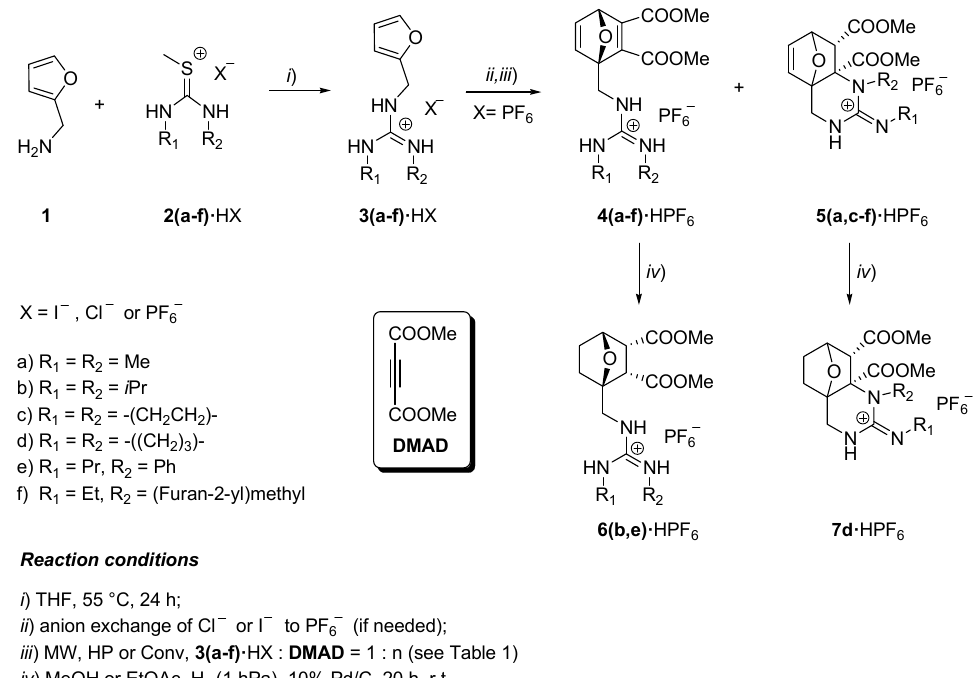
Scheme 1. Cycloaddition of furfurylguanidine hexafluorophosphates ( 3(a − f)· HPF 6 ) with DMAD . Hydrogenation was conducted only for the selected